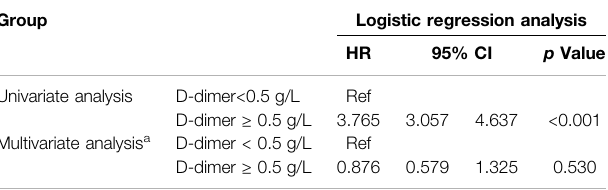
TABLE 4 | The risk of elevated D-Dimer for the disease mortality of COVID-19.